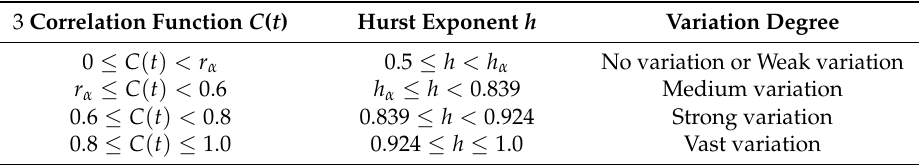
Table 1. Classification of variation